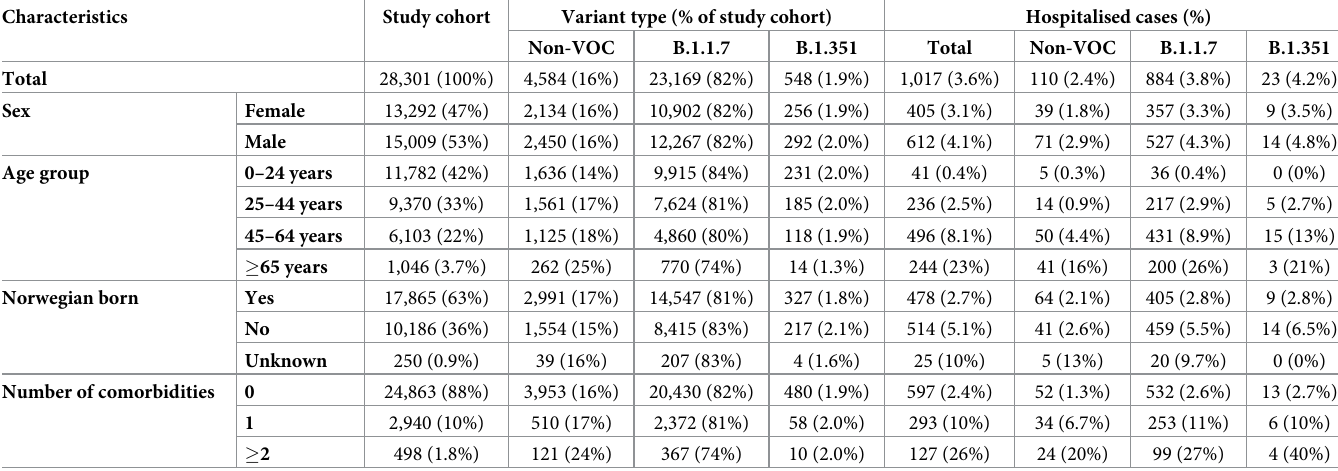
Table 1. Distribution of cases in study cohort by detected variants for different characteristics and proportion hospitalised, Norway, December 2020—May 2021. Characteristics